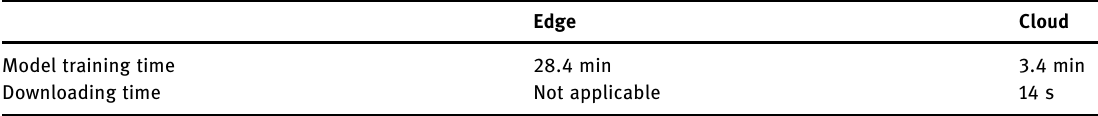
Table 5: Comparison of model training